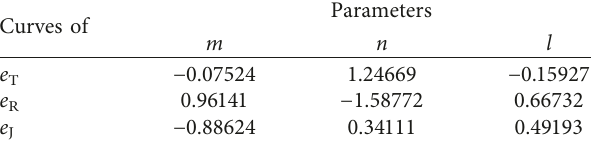
Table 7: Parameters of the fitted curves (energy coefficients: JMC). Curves of